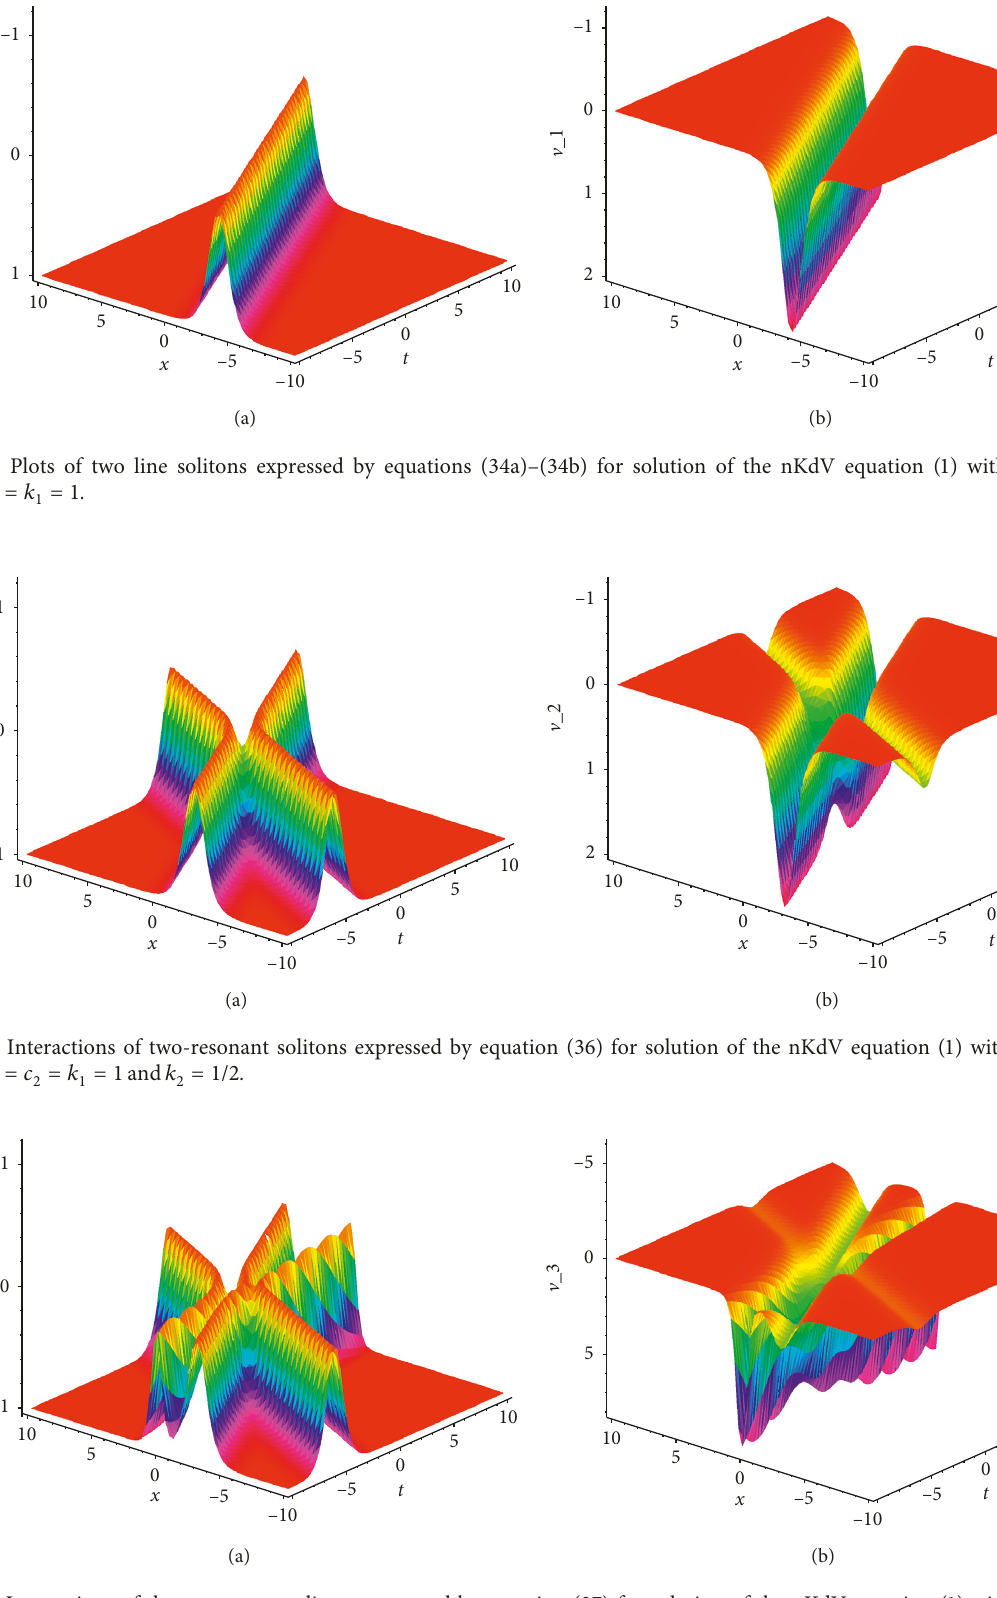
Figure 3: Interactions of three-resonant solitons expressed by equation (37) for solution of the nKdV equation (1) with the parameters a � ε � c � c � c � k � 1 ,k � 1/2 , and k � 2 . 1 2 3 1 2 3